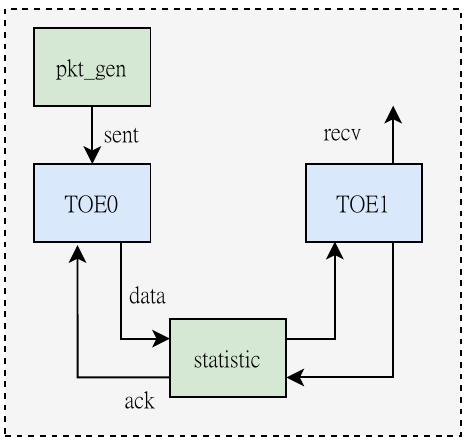
Figure 6. Diagram of test signal